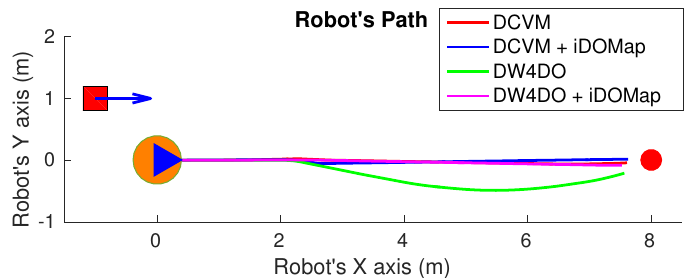
Figure 27. Scenario 1—Robot’s Paths.